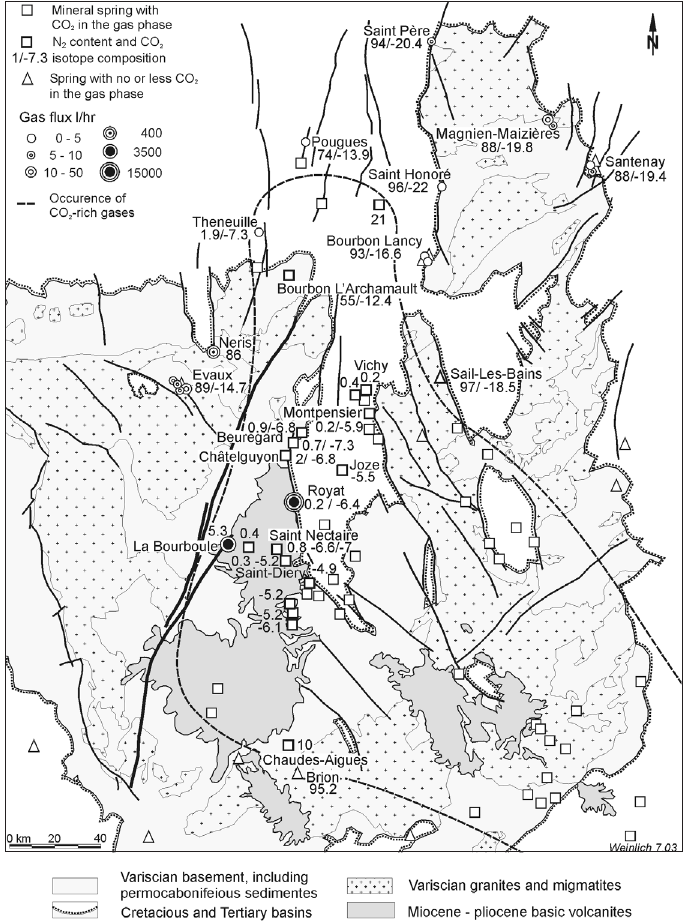
Fig. 3. Distribution of gas flux (free gas), gas composition and δ 13 C CO2 values of the gases of the mineral springs of the French Massif Central. Compiled after data from Moureu and Lepape (1912), Moureu (1923), Baubron et al . (1979), Schoeller and Schoeller (1979), Batard et al . (1982) and Matthews et al . (1987). Based on the hydrologic map (Risler et al ., 1973) and tectonic map (Autran et al .,